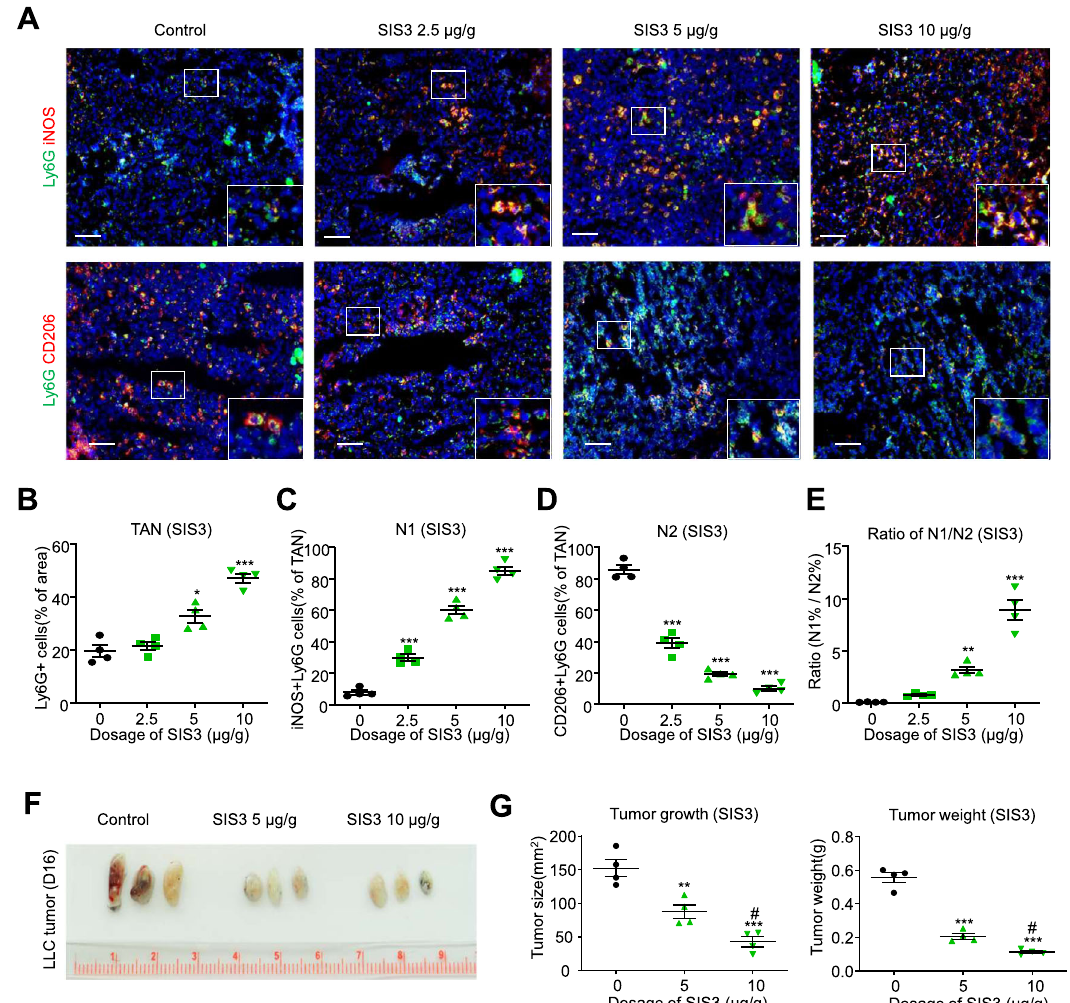
Fig. 8 | Pharmaceutical inhibition of Smad3 promotes an N1 phenotype and suppresses tumor growth. On day 7, after inoculation with LLC cells, Smad3-WT mice received daily administration of different doses of the Smad3 inhibitor, SIS3, or vehicle, until mice were killed on day 16. Immunostaining shows that SIS3 treatment increased the proportion of neutrophils (Ly6G + cells) within the TME ( A , B ), increased the proportion of N1 (iNOS + Ly6G + ) TANs ( C ), decreased the proportion of N2 (CD206 + Ly6G + ) TANs ( D ), changed the ratio of the N1/N2 phe- notypeinTANs( E ),andsuppressedLLCtumorgrowthandweight( F , G ).(* P <0.05, ** P <0.01,*** P <0.001vs.vehiclecontrol,# P <0.05,## P <0.01vs.SIS35 μ